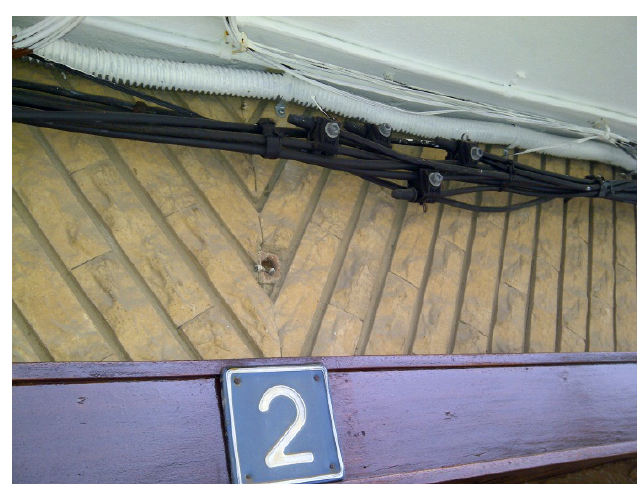
Figure 3. LV cables on a street wall.